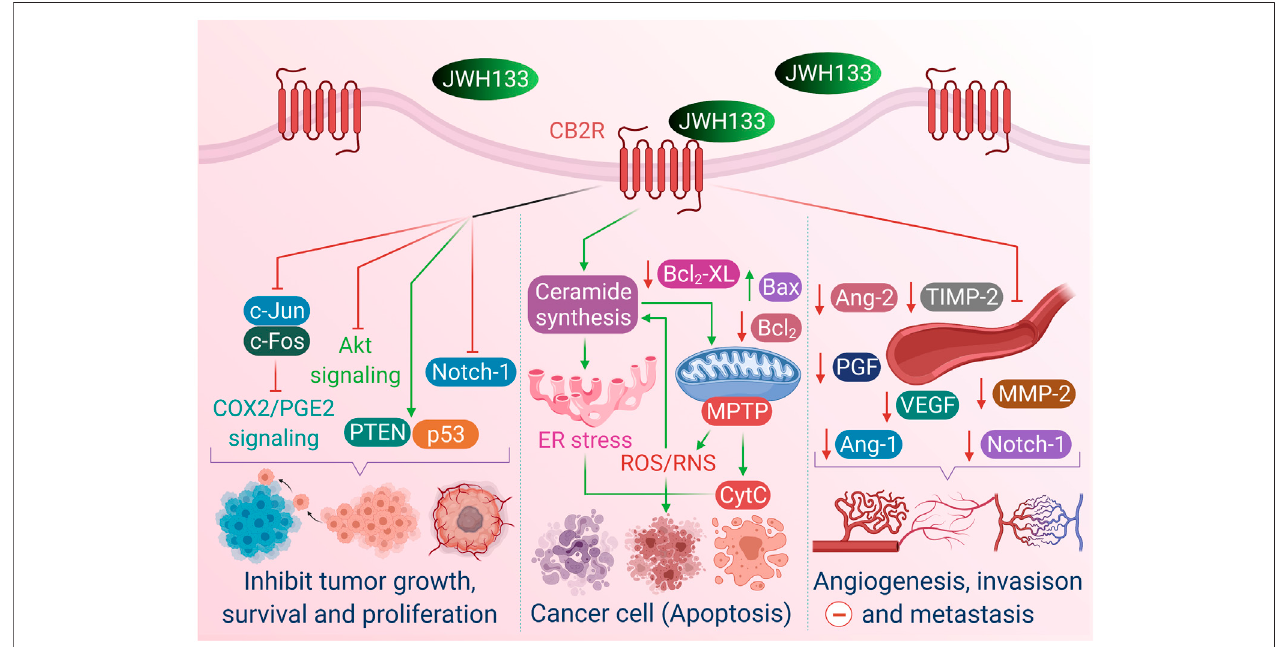
FIGURE 3 | The anticancer properties, effects and mechanism of